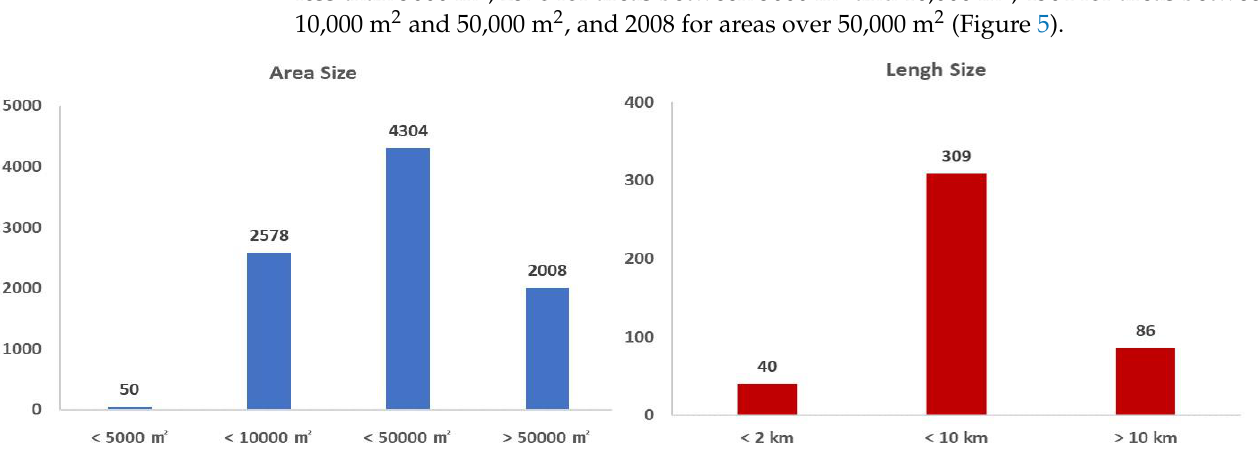
Figure 6. Consultation results and methods (2015 – 2017).